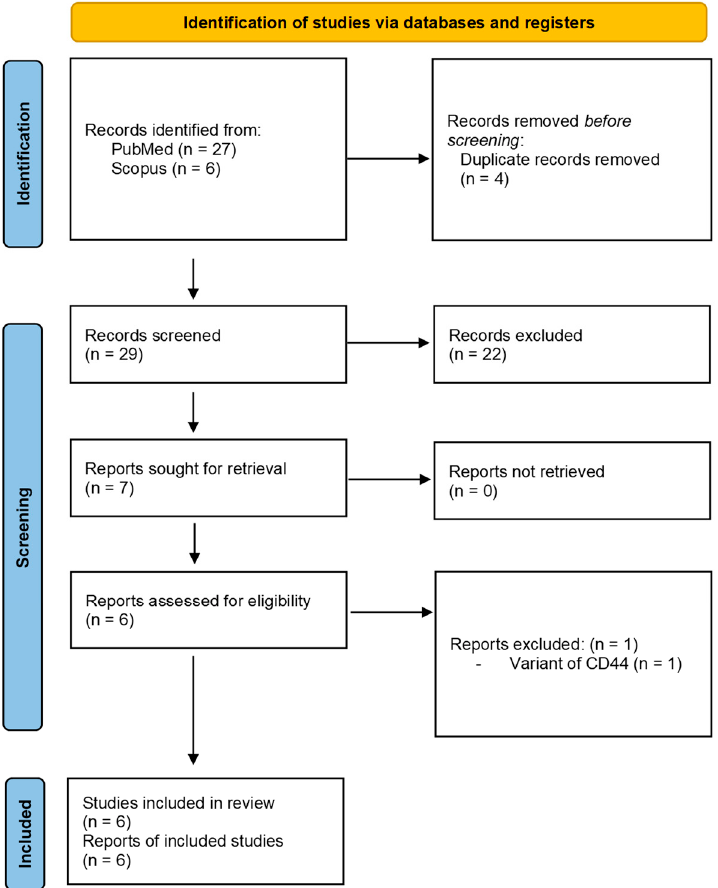
Figure 1. PRISMA flowchart showing the study selection Figure 1. PRISMA fl owchart showing the study selection process.